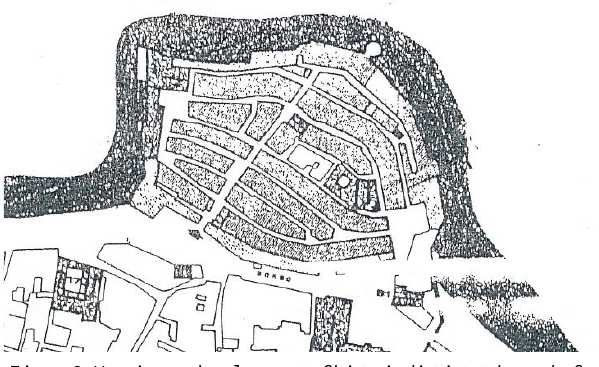
Figure 3. Maximum development of historic district at the end of XVIII century. Source: Retrofit plan of historic district (1994).